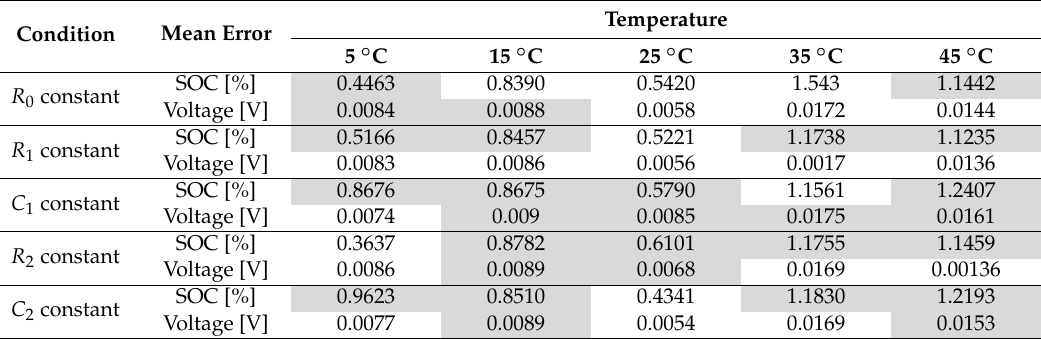
Table 6. Sensitivity analysis of the error of the SOC and battery voltage. Mean